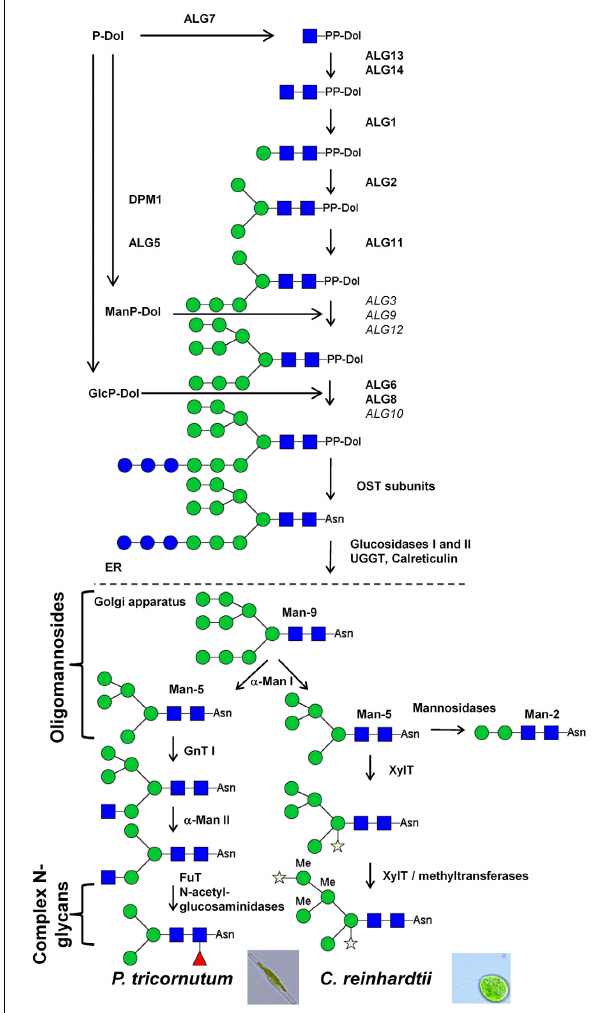
FIGURE 2 | Comparison of the N-glycosylation pathways in P. tricornutum and C. reinhardtii . In both microalgae, mature N- linked glycans have been structurally characterized. Genomic data are in agreement with the biochemical ones and are summarized in this figure. Sequences predicted in both C. reinhardtii and P. tricornutum genomes are written in bold. ALG10 in P. tricornutum genome and ALG3 , 6 and 12 in C. reinhardtii genome have not been identified yet. The N -glycan structures presented in this figure are annotated according to the symbolic nomenclature adopted by the Consortium for Functional Glycomics (Varki et al., 2009). DPM1: Dolichol-phosphate mannosyltransferase;